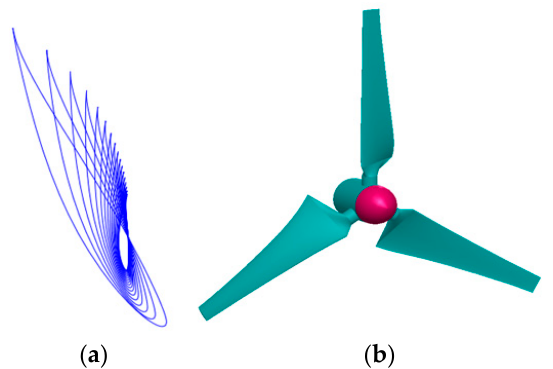
Figure 5. Ocean current turbine design results. ( a ) Blade element section at different blade heights; ( b ) Ocean current turbine modeling.